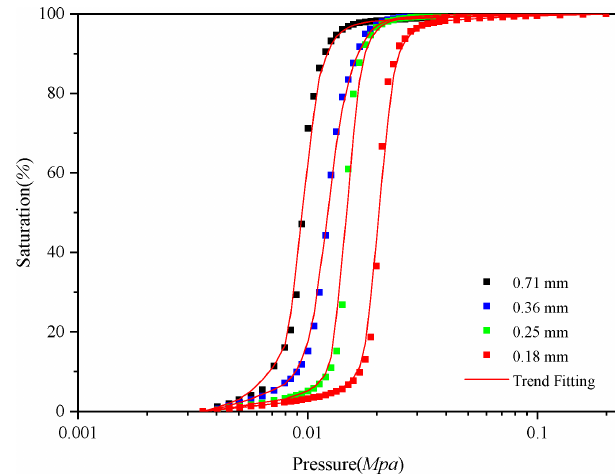
Figure 6. Schematic diagram of the change in pressure with the saturation: the initial stage (A–B), the intermediate mercury entry stage (B–C) and the end stage (C–D) are shown.